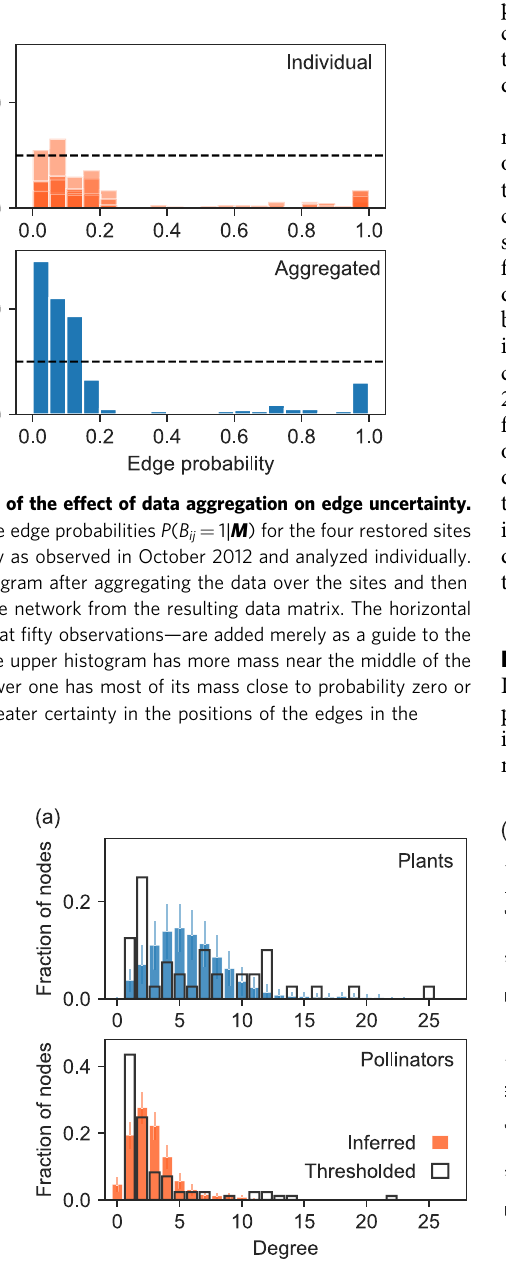
Fig. 5 Distributions of species-level parameters for a network of plants and pollinators in Kosciusko National Park, Australia, from the study by Inouye and Pyke 44 . a Thresholded degree distributions calculated by connecting species i and j with an edge if M ij > 0. Inferred degree distributions are calculated using the method of this paper, averaging the fraction p k of nodes with a given degree k over n = 2000 Monte Carlo samples. b Inferred distributions of abundances σ and τ , calculated as a histogram over n = 2000 Monte Carlo samples of the abundance parameters of the fi tted model. Error bars correspond to one standard deviation in all